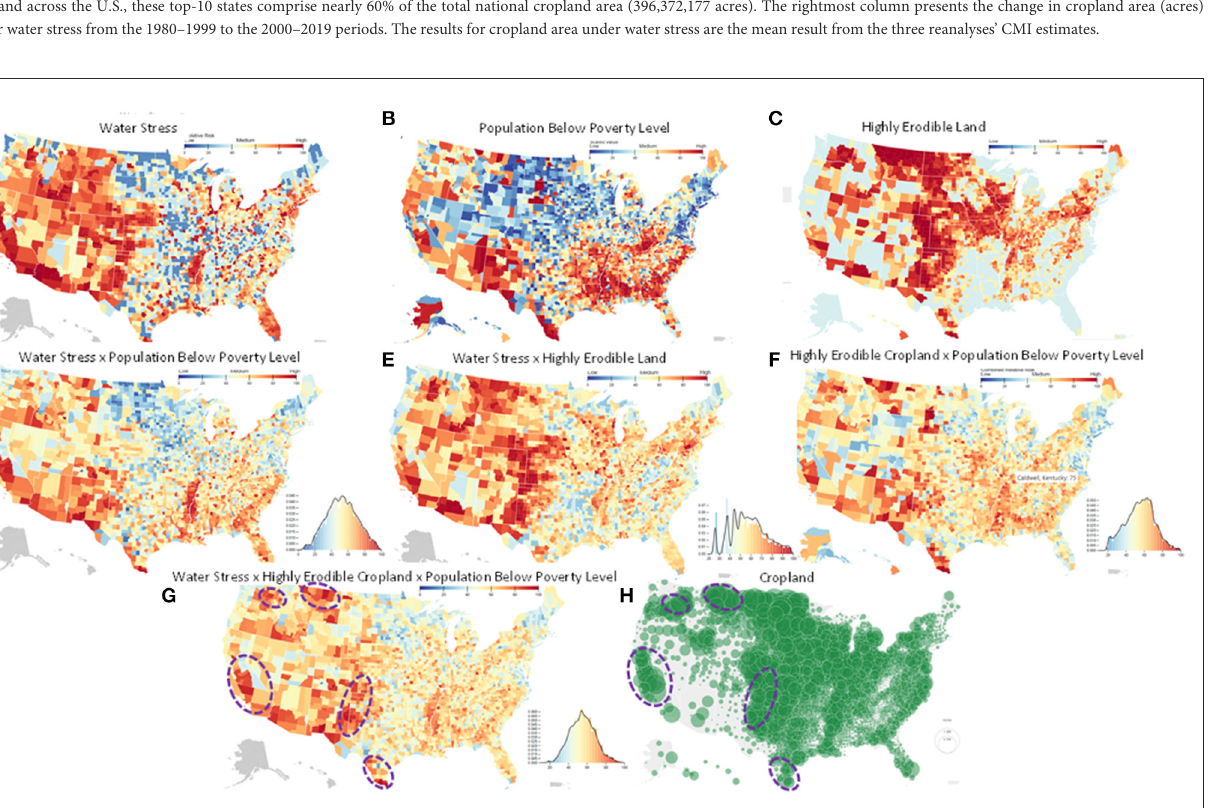
climate moisture index is around 0 for this area (not shown) which means it is not an area of extreme heat or cold on average. There is a concern when looking at the 100-year flood as the results show that this area is under high risk (Figure